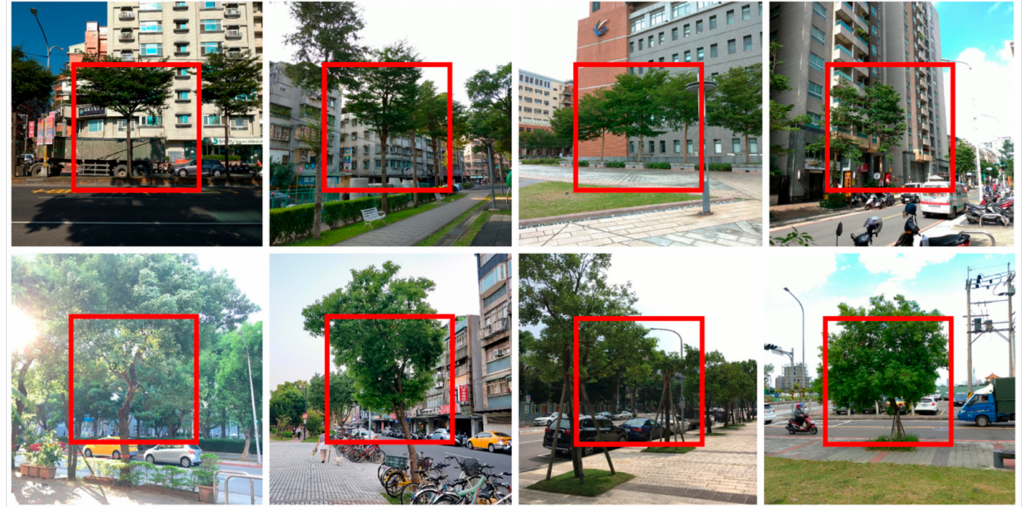
Figure 2. Samples of interfering backgrounds in the training dataset. Images in the upper row demonstrated redundant buildings and roads while in the lower row showed cars and sky as interfering background. The red boxes are the central attention part that would be cropped in the center as the input for central attention path in the dual path